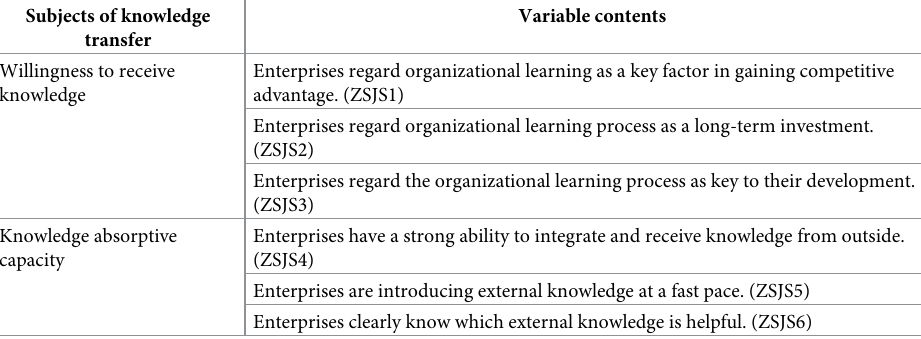
Table 4. Knowledge transfer subject measurement